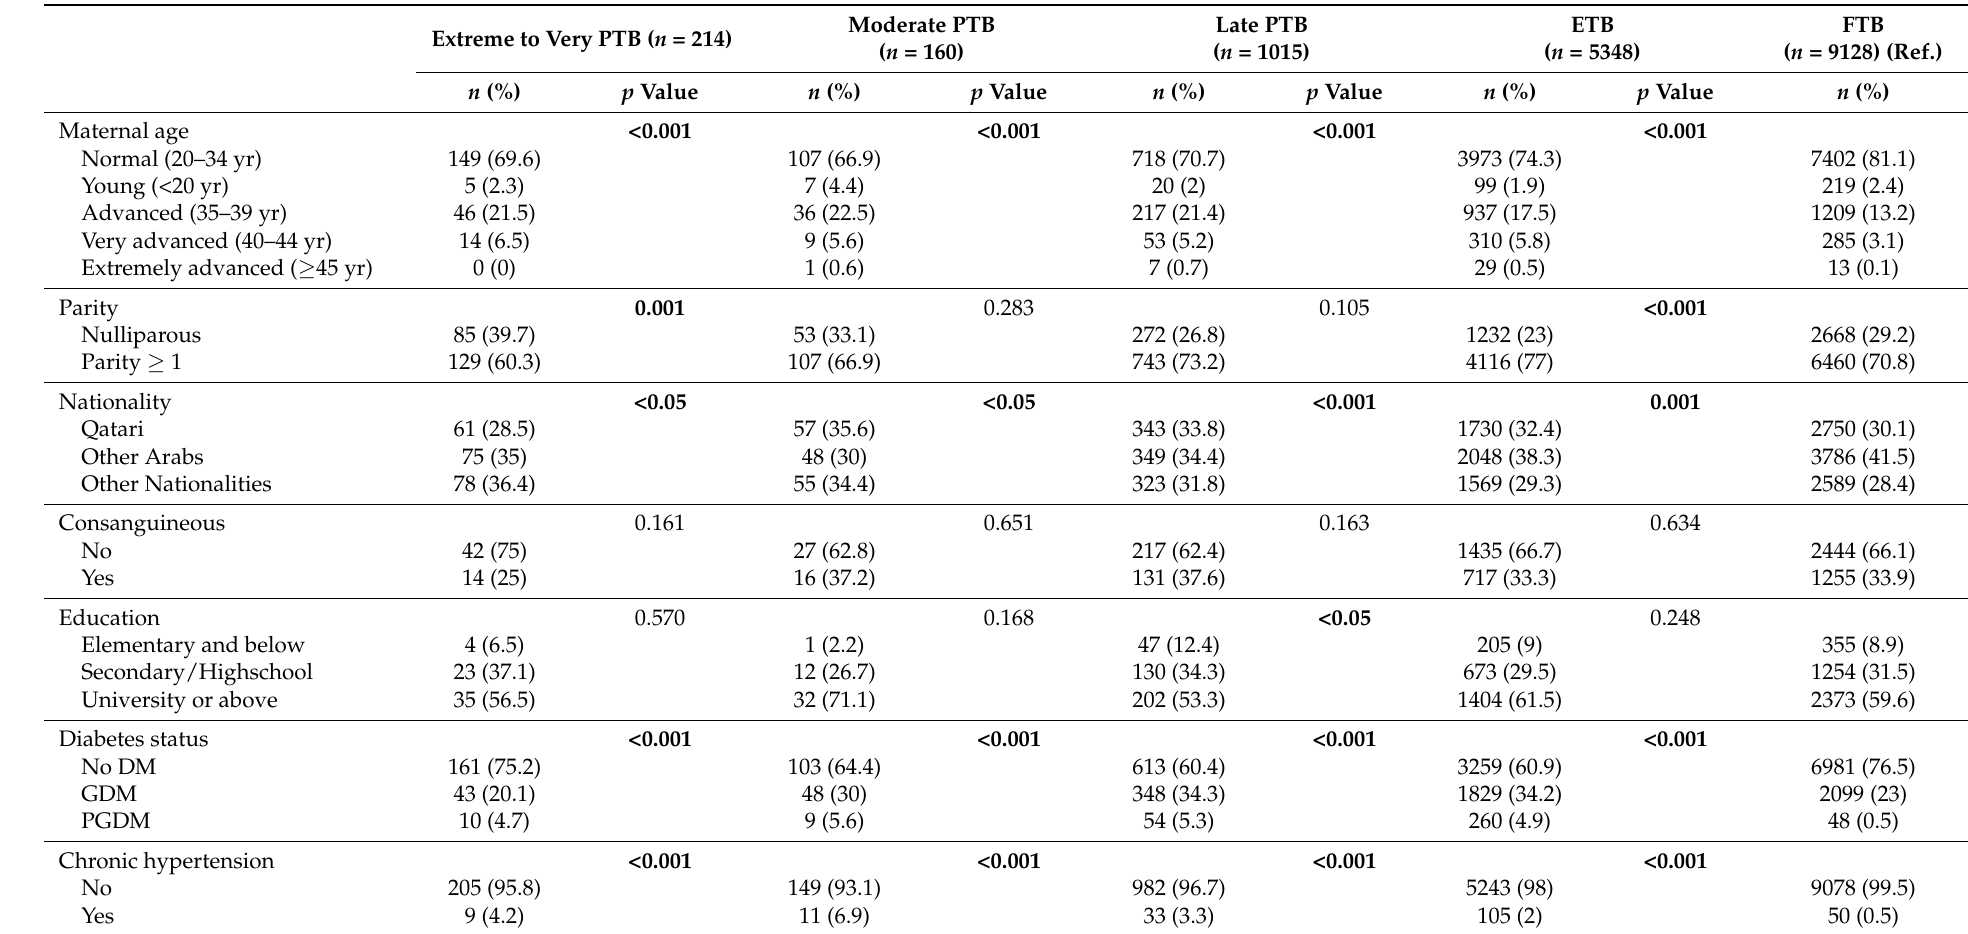
Table 1. Characteristics of the study population according to gestational age groups: differences between each PTB and ETB group in comparison to FTB in relation to various demographic and medical